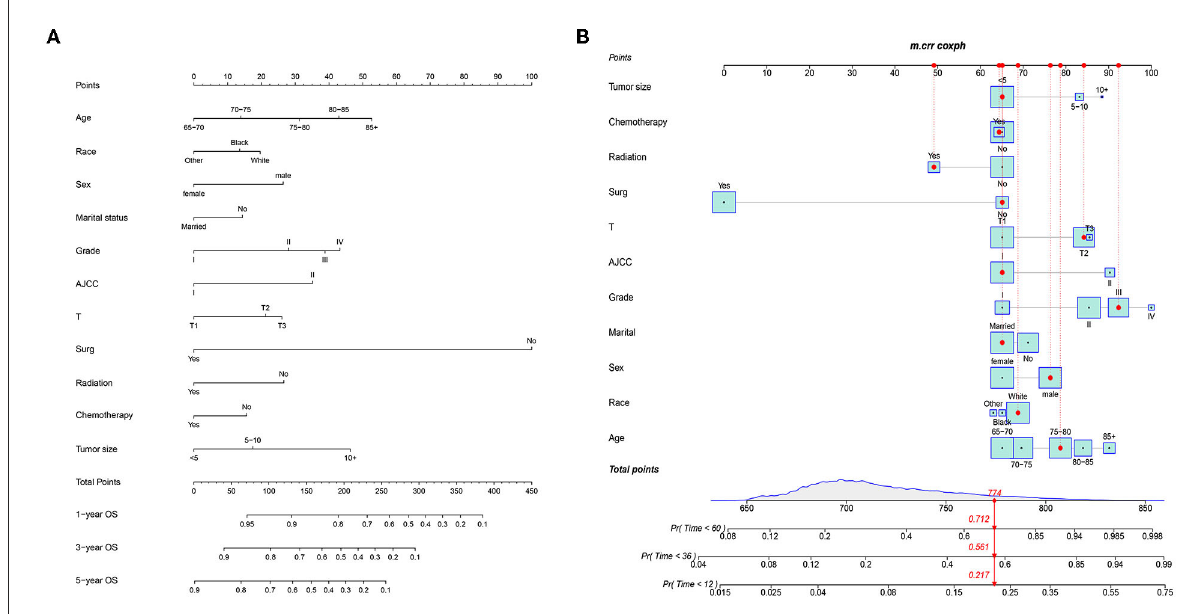
FIGURE2 Prognostic nomograms of 1-, 3-, and 5-year OS (A) and CSS (B) .